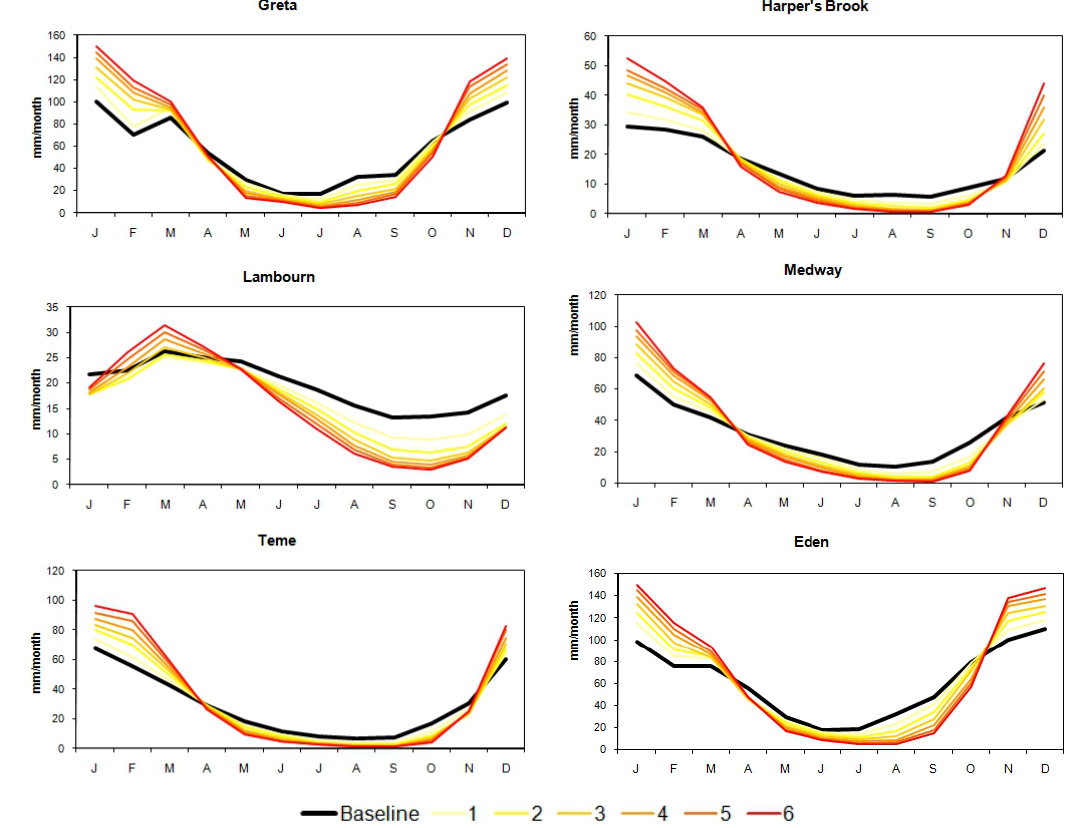
Fig. 5. Mean monthly runoff for each catchment with increases in global mean temperature between 1 and 6 ◦ C: HadCM3 climate model